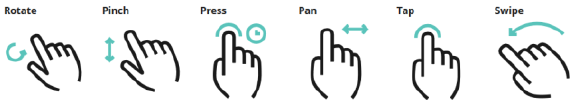
Fig. 1. Gestures detected by Hammer.js library (source: